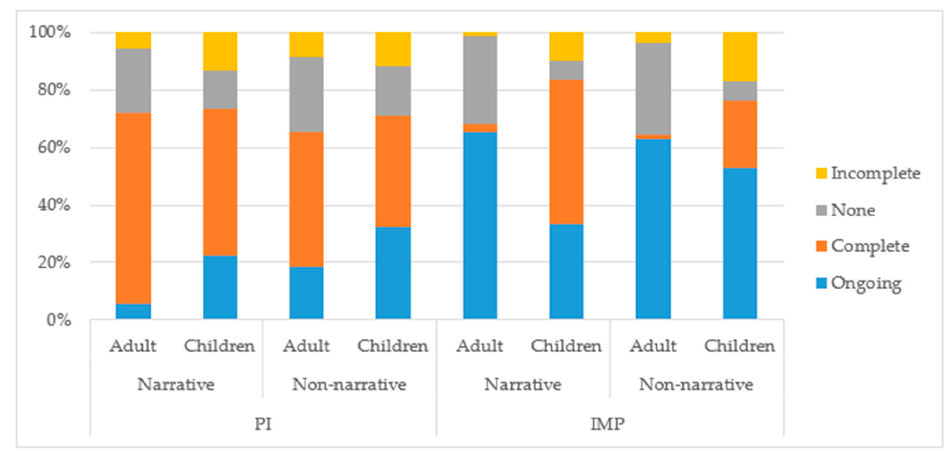
Figure 3. Distribution of picture choices per age group and experimental setting.